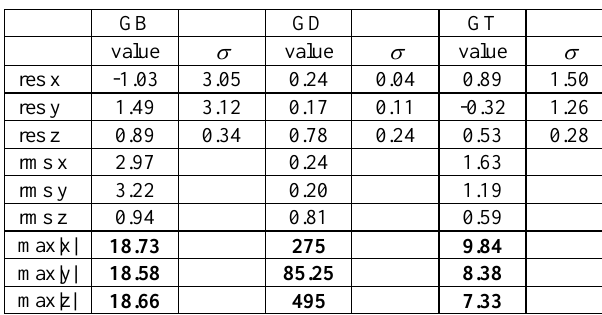
Table 6: Average residual (res), root mean square (rms) and maximal absolute residual value (max|v|) of all check points in mm (7MB dunk).